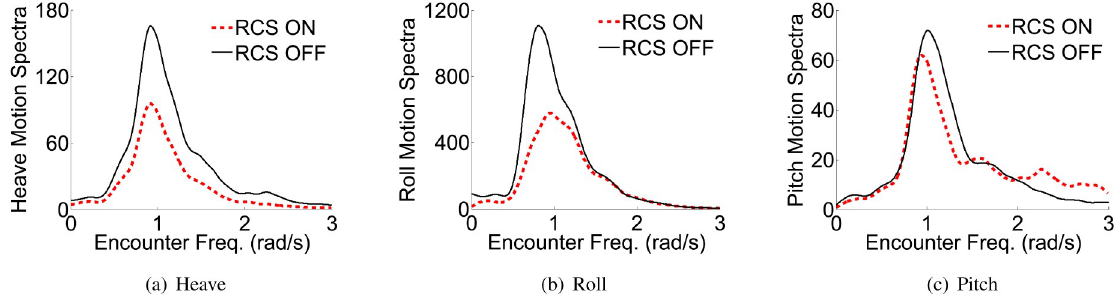
Fig 11. Heave, roll and pitch motion spectra with and without RCS. (a) Heave. (b) Roll. (c) Pitch.